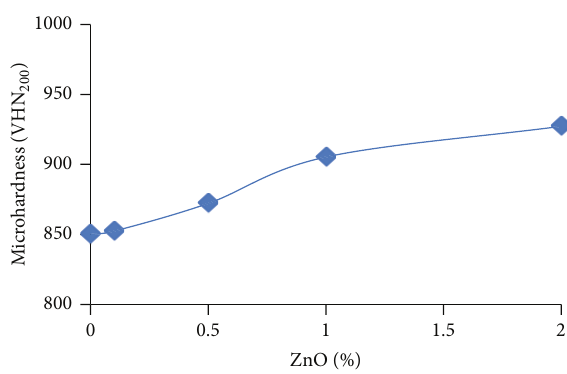
Figure 11: Variation in average surface roughness of EN-coatings as a function of ZnO with surfactant (SLS) concentration in the EN bath.